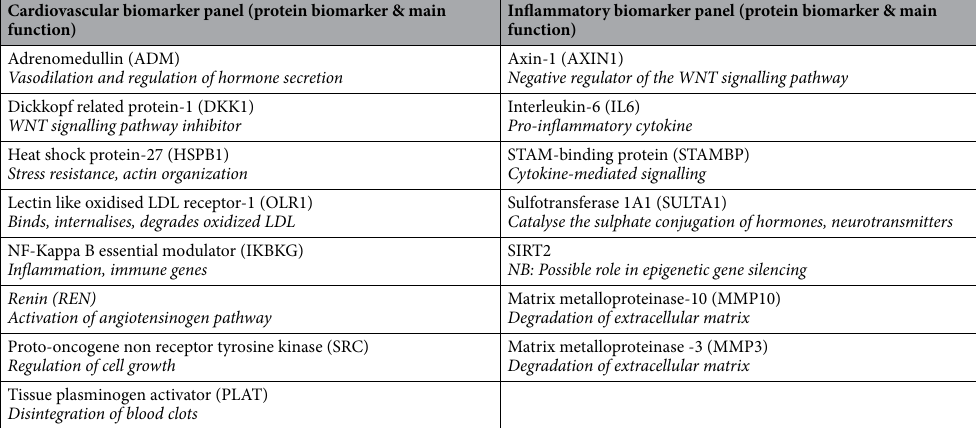
Table 1. Protein biomarkers which were differentially expressed after the DI. The column on the left displays differentially expressed proteins from the CVD panel and the column on the right displays differentially expressed proteins from the inflammation